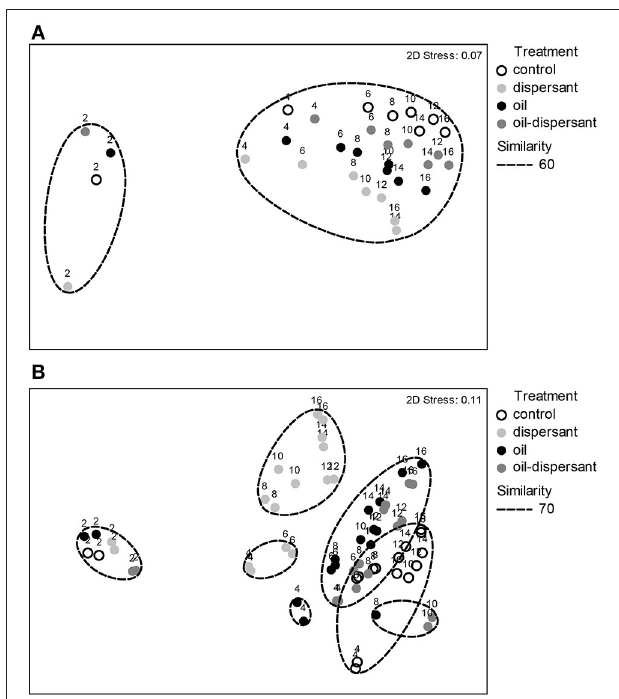
FIGURE 3 | (A) Non-metric multidimensional scaling ordination of square-root-transformed Bray-Curtis dissimilarities calculated for carbon steel disk (CSD) biofilm samples ( n = 32). Each point represents a discrete sample. Superscripts denote time (weeks) sampled. The dashed line delineates the 60% Bray-Curtis similarity threshold. (B) Non-metric multidimensional scaling ordination of square-root-transformed Bray-Curtis dissimilarities calculated for SW bacterioplankton samples, with 2 replicates per time point ( n = 72). Superscripts denote time (wks) sampled; t = 0 data excluded. The dashed line delineates the 70% Bray-Curtis similarity